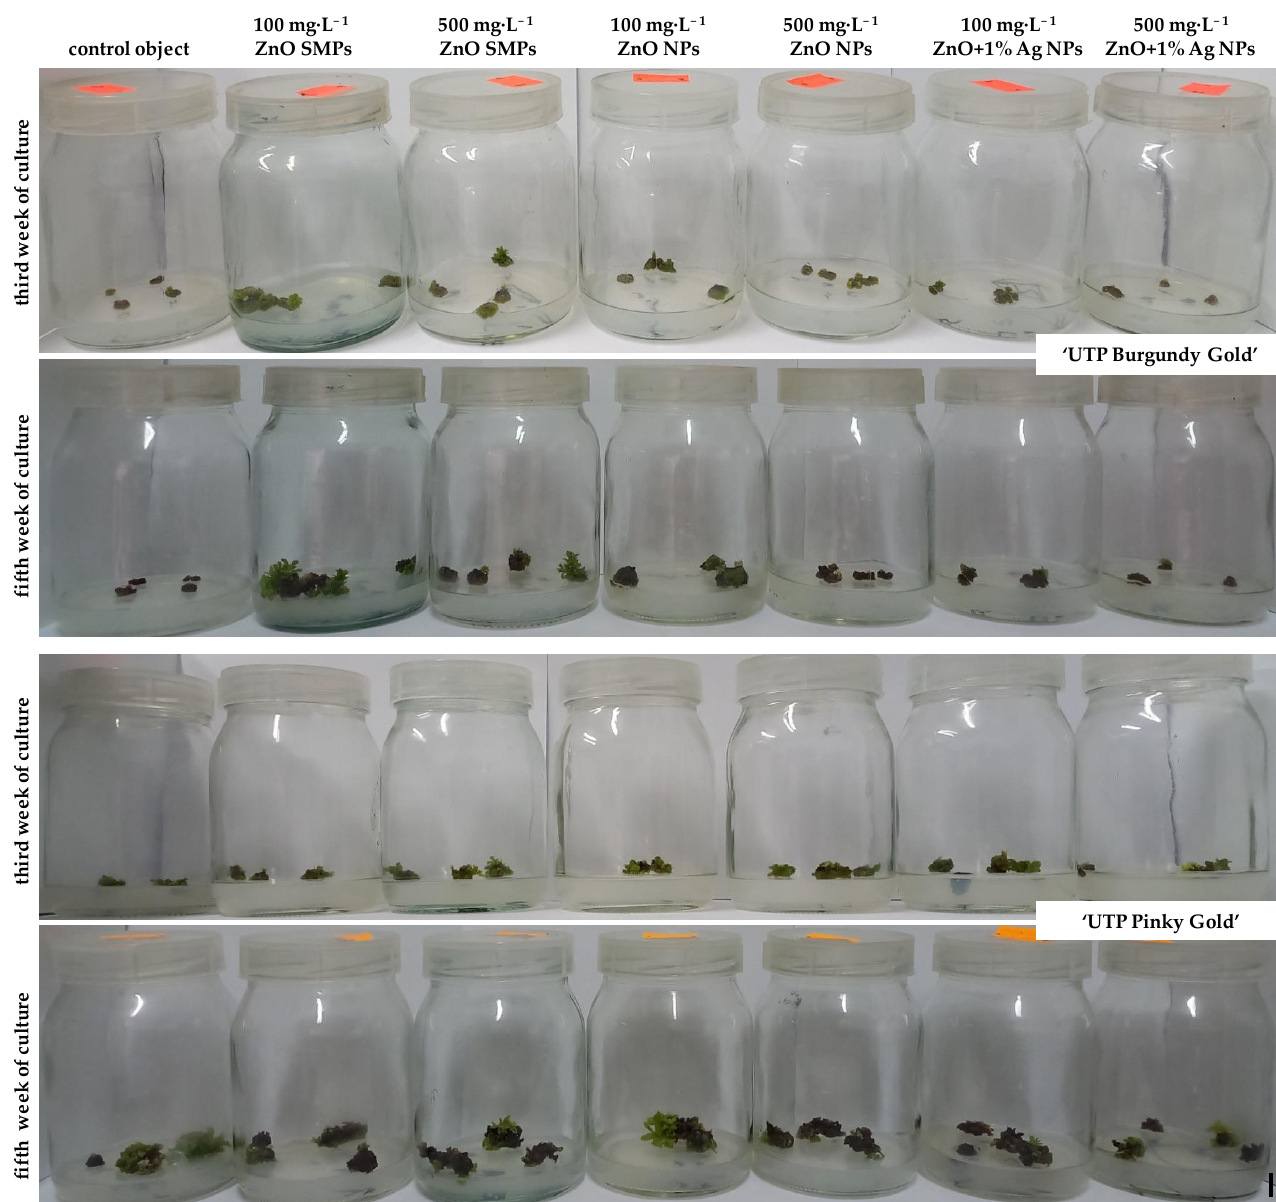
Figure 6. Regeneration of adventitious shoots on Chrysanthemum × morifolium ‘UTP Burgundy Gold’ and ‘UTP Pinky Gold’ internodes cultured on the modified MS medium with 0.6 mg·L −1 BAP and 2 mg·L −1 IAA, depending on the experimental treatment and culture week; bar = 1 cm.